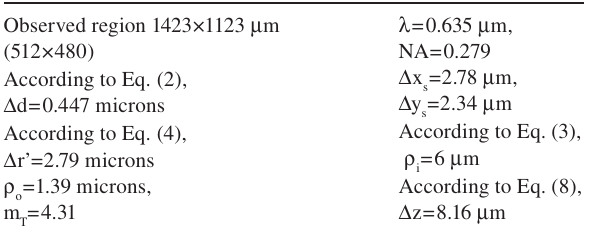
λ = 0.635 µ m, NA = 0.279 ∆ x = 2.78 µ m, s ∆ y